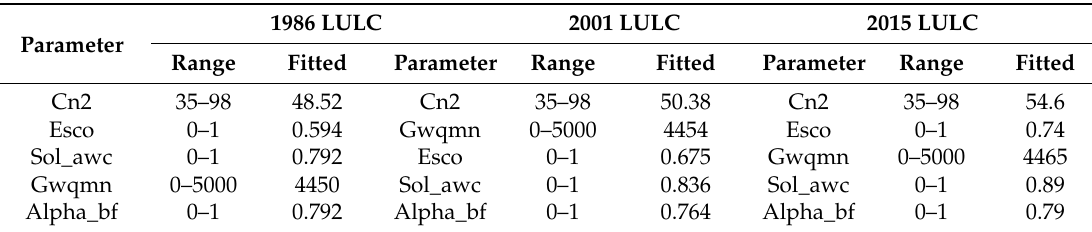
Table 3. Selected parameters for model calibration and validation.